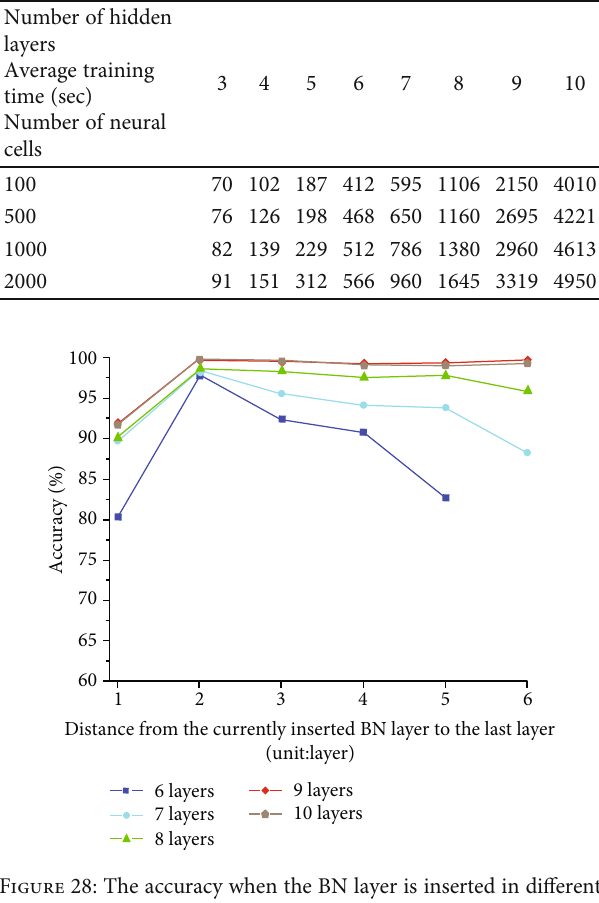
Figure 28: The accuracy when the BN layer is inserted in di ff erent locations of hidden